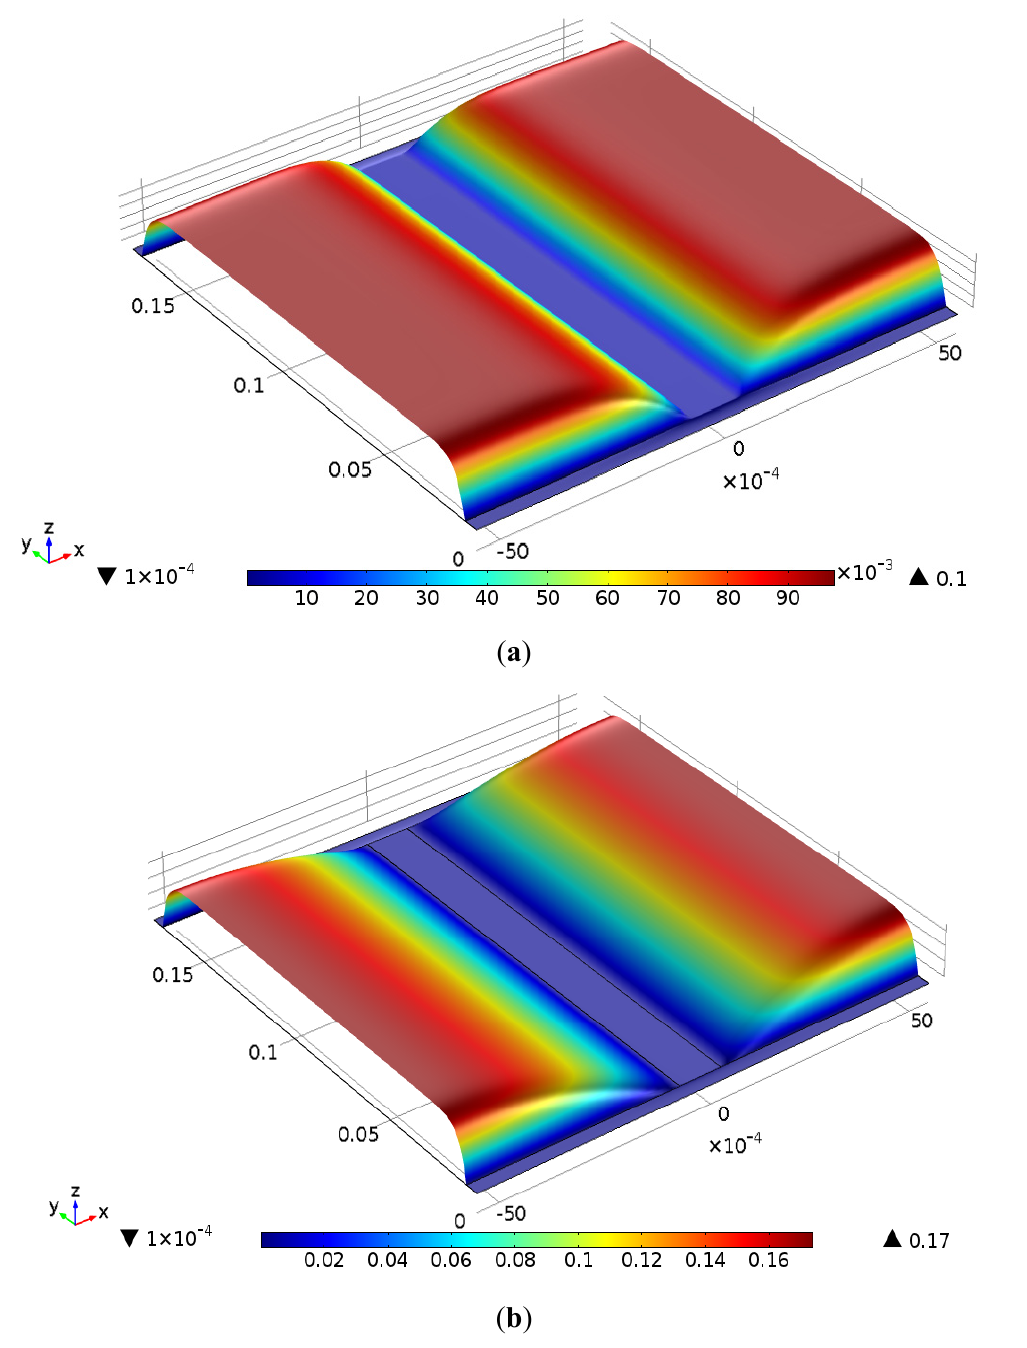
Figure 7. PV cell surface voltage distribution under the short circuit condition for: ( a ) Profile 3; ( b ) uniform illumination distribution, x-axis is the bus bar direction (m) and y-axis is the finger direction